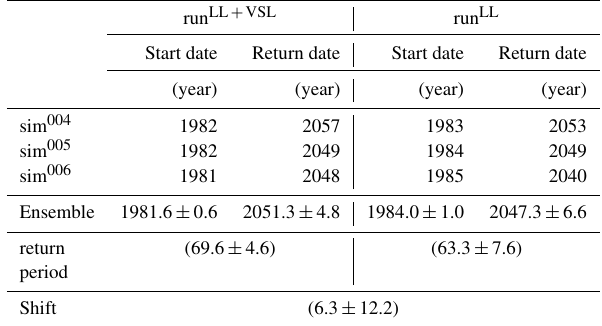
is observed during July